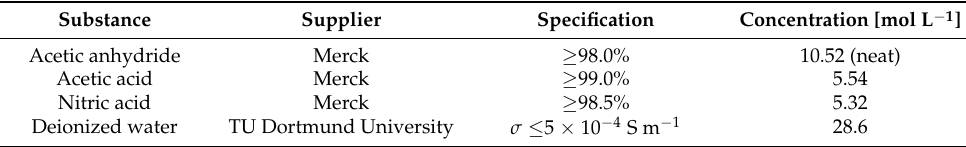
Table 3. Substances and concentrations used for hydrolysis of acetic